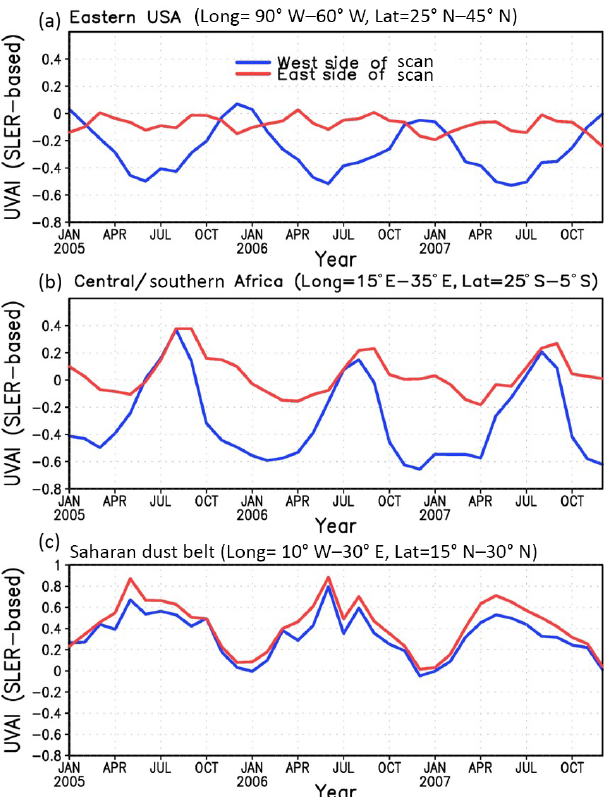
Figure 7. Time series of monthly averages of retrieved AOD (a) , SSA (b) , and AAOD (c) over the Sahara Desert. Retrievals carried out using an OMI research algorithm that accounts for aerosol non- sphericity. Line color interpretation same as in Fig. 3.